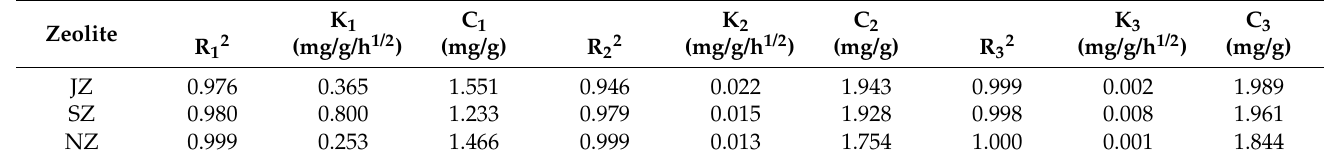
Table 3. Fitting parameters of Cd diffusion in particles by modified